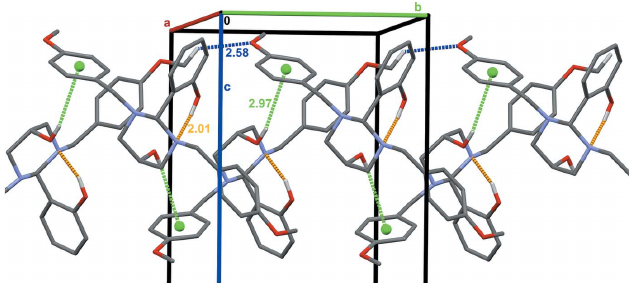
Figure 3 The crystal packing of the title compound, showing the intermolecular C—H (cid:2)(cid:2)(cid:2) O hydrogen-bonding interactions (blue dashed lines) and O— H (cid:2)(cid:2)(cid:2) (cid:2) (green dashed lines) interactions along the b axis. Intramolecular O—H (cid:2)(cid:2)(cid:2) N hydrogen bonds are depicted in orange. Only the H atoms involved in the C—H (cid:2)(cid:2)(cid:2) O, O—H (cid:2)(cid:2)(cid:2) N and O—H (cid:2)(cid:2)(cid:2) (cid:2) interactions are shown for